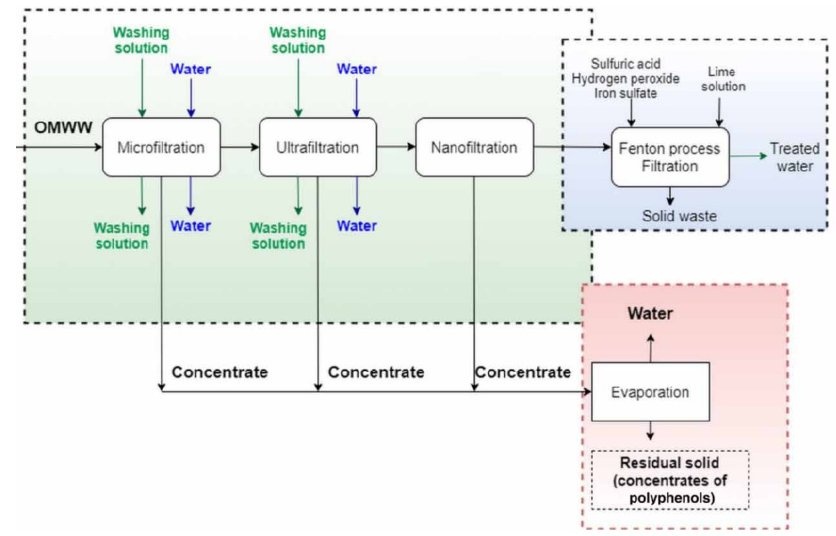
Figure 14. Treatment of OMW that contains pesticides [233].